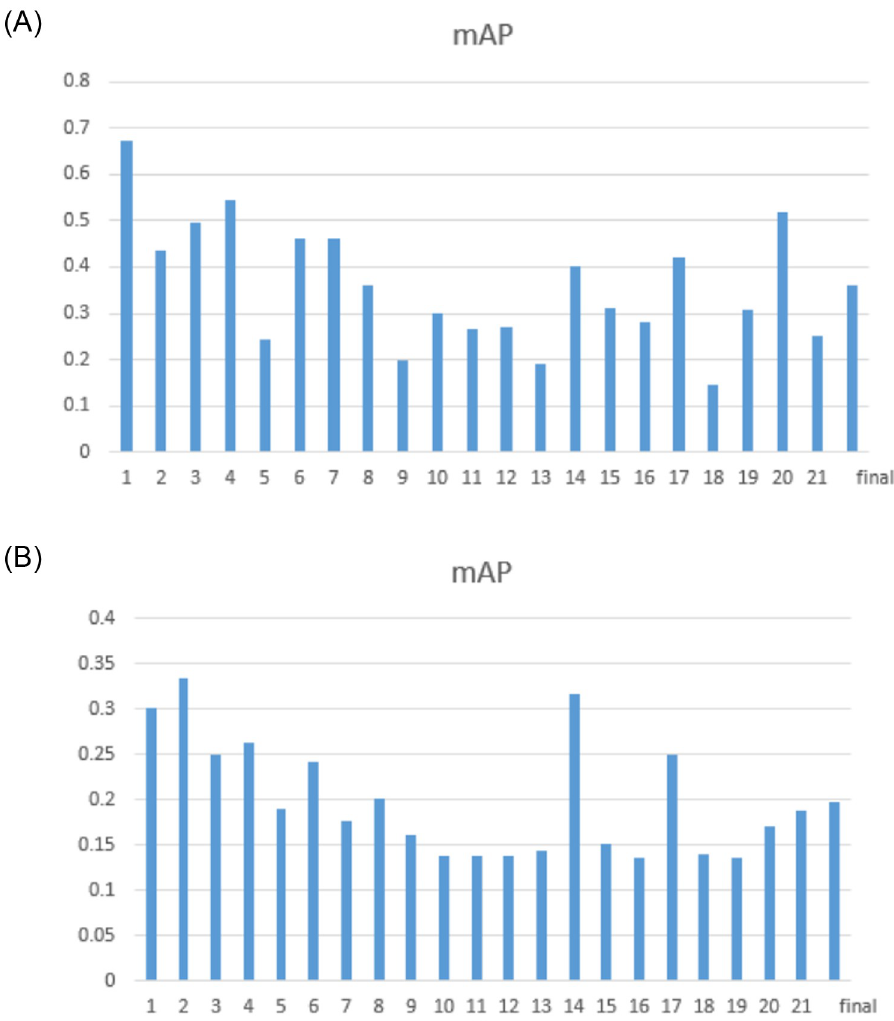
Fig 12. A comparison of image retrieval results with two deep learning features using